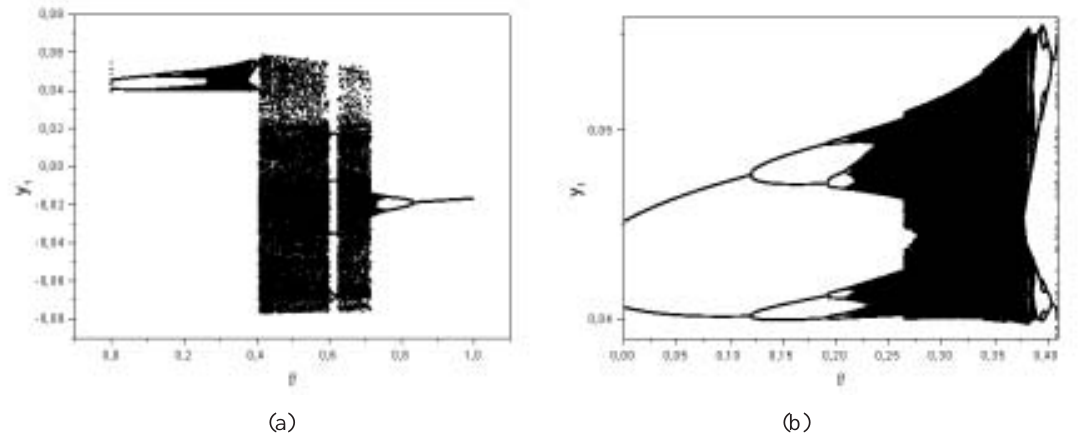
Fig. 13. Bifurcation diagram varying temperature parameter θ . (a) 0 < θ (cid:1) 1 ; (b) 0 < θ (cid:1) 0 . 405